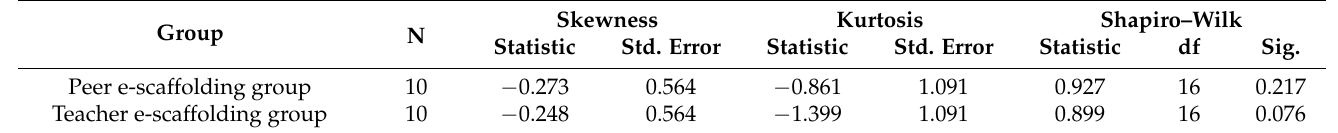
Table 2. Normality test of the experimental